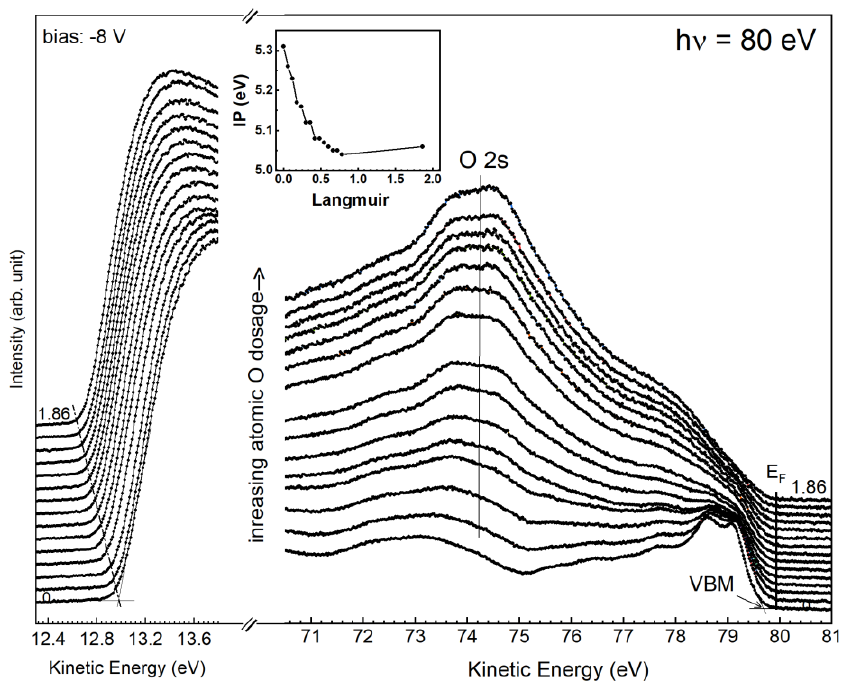
Figure 7. The acquired valence-band and cutoff spectra taken with 80 eV photon energy with various atomic-O coverages. The inset shows the change of the ionization potential (IP).